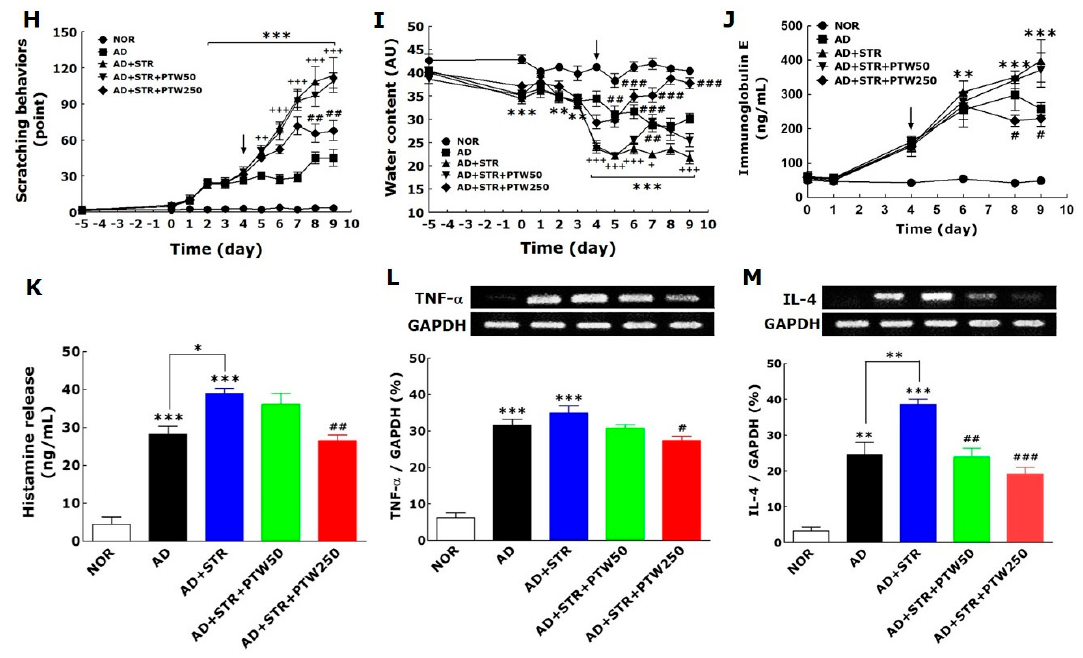
Figure 2. Inhibitory effect of Polygala tenuifolia Willd. (PTW) on immobilization (IMO) stress-exacerbated atopy-like skin symptoms in the mouse model of trimellitic anhydride (TMA)-induced contact hypersensitivity. Schematic diagram of the in vivo experimental schedule ( A ), and representative images of mouse ears ( B ) and their histological sections ( C ) are presented: a: auricular cartilage; d: dermis; e: epidermis in the vehicle-treated and IMO stress-exacerbated atopic group (AD + STR). Enlarged histological figures in black squares in the lower right corners indicate the infiltration of inflammatory cells in dermis layers. Arrows in the squares indicate immune cells such as neutrophil or eosinophil. Scale bar in non-treated normal group (NOR) indicates 100 µm. Skin score ( n = 10) ( D ) indicating atopic dermatitis severity based on the mouse ear images, ear thickness ( n = 10) ( E ), lymph node weight ( n = 10) ( F ), blood corticosterone levels ( n = 5) ( G ), scratching behavior ( n = 10) ( H ), skin water content ( n = 10) ( I ), and serum levels of immunoglobulin E (IgE) ( n = 5) ( J ), and histamine ( n = 5) ( K ) in each group are also presented in the graphs. Arrows in E, F, G, H, I and J indicate the initiation of IMO stress on day four. The mRNA expression levels of tumor necrosis factor (TNF)- α ( n = 5) ( L ) and interleukin (IL)-4 ( n = 5) ( M ) in ear skin tissues are also presented in polymerase chain reaction (PCR) band images and bar graph. Ear tissues were collected from five mice randomly selected in each group. AU, arbitrary unit; PTW, Polygala tenuifolia Willd.; TMA, trimellitic anhydride; IMO, immobilization; GAPDH, glyceraldehyde 3-phosphate dehydrogenase. * p < 0.05, ** p < 0.01, and *** p < 0.001 vs. the NOR group; # p < 0.05, ## p < 0.01, and ### p < 0.001 vs. the AD + STR group; + p < 0.05, ++ p < 0.01, and +++ p < 0.01 vs. the vehicle-treated and TMA-induced atopic group (AD).